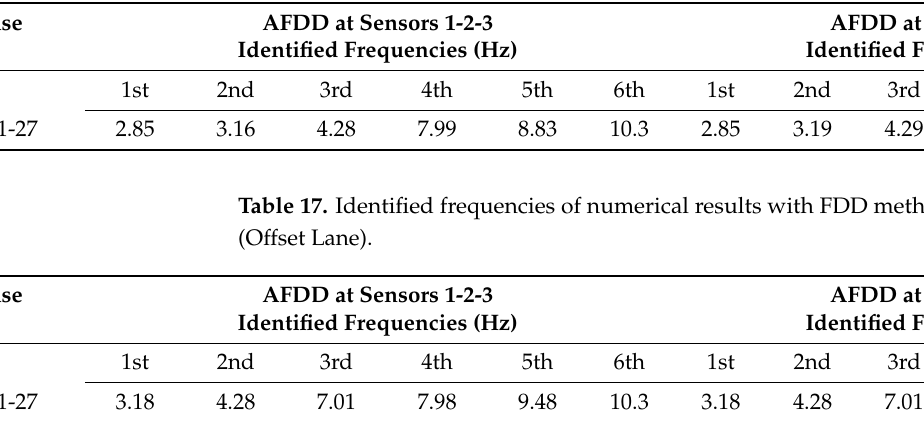
Table 16. IdentifiedfrequenciesofnumericalresultswithFDDmethodintheverticaldirection(OffsetLane).